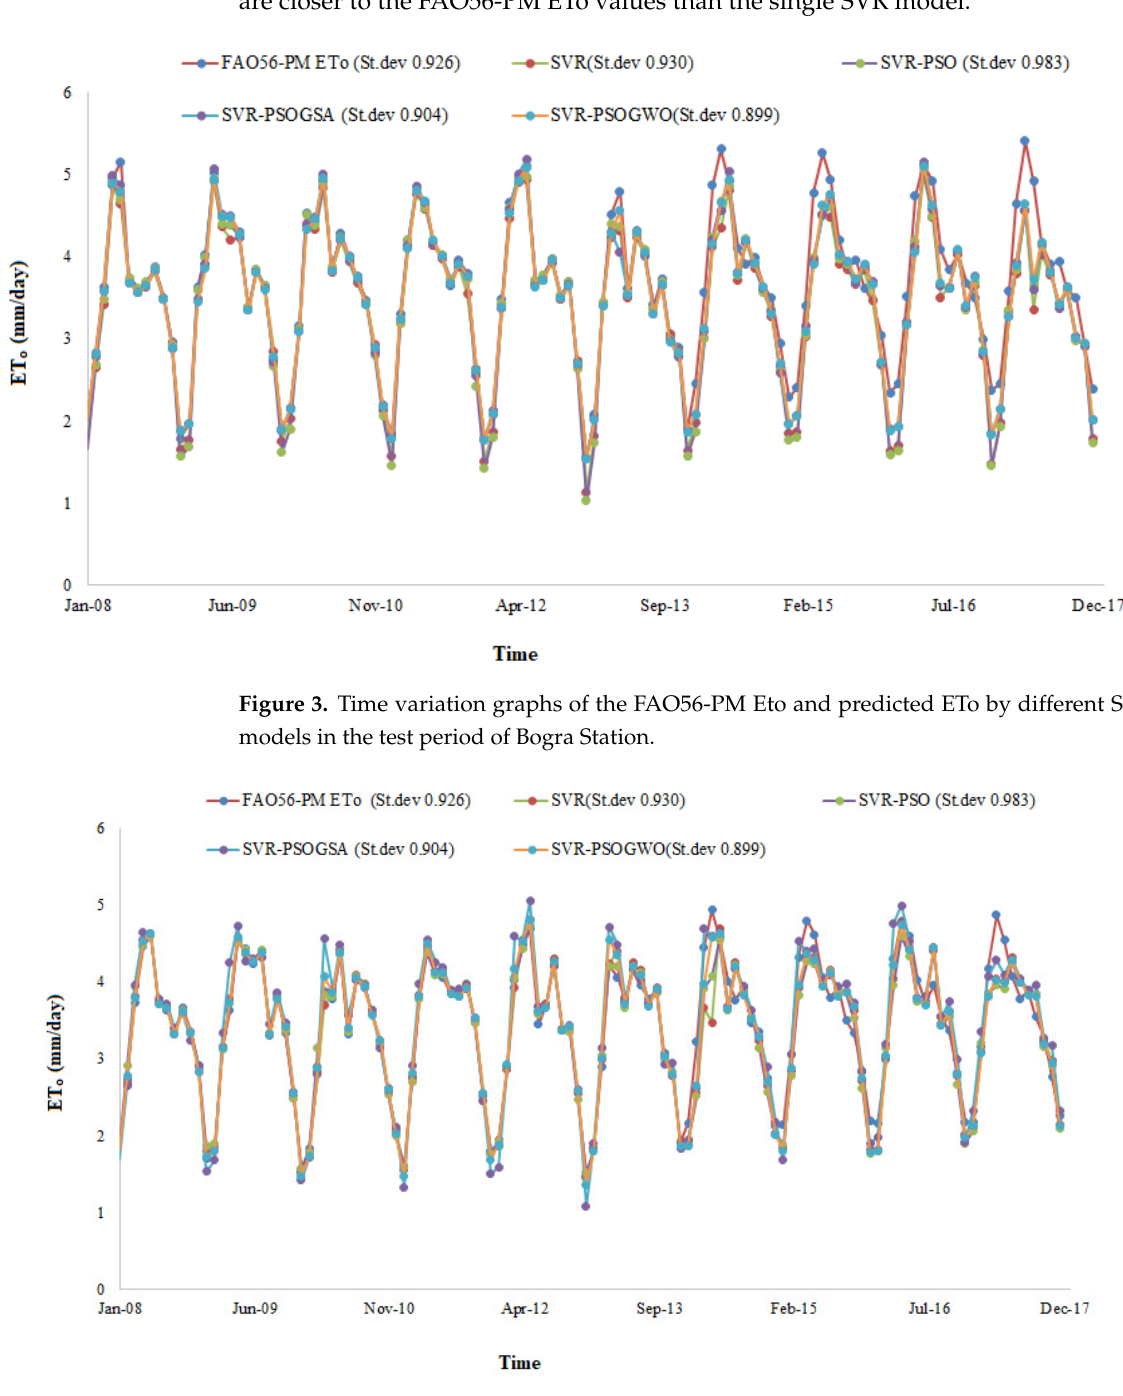
Figure 4. Time variation graphs of the FAO56-PM Eto and predicted ETo by different SVR-based models in the test period of Rajshahi